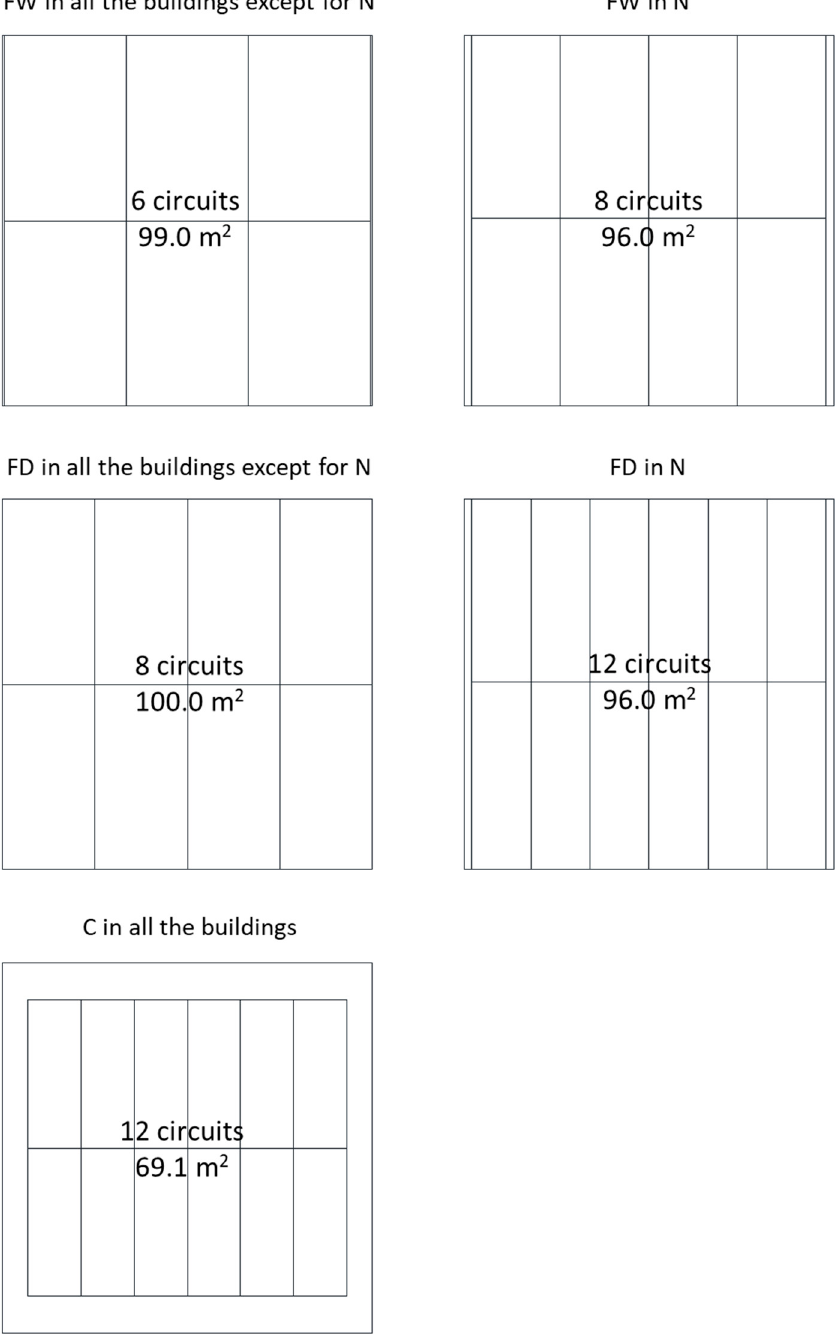
Figure 4. Number of circuits and active area of the radiant systems implemented in DIGITHON.